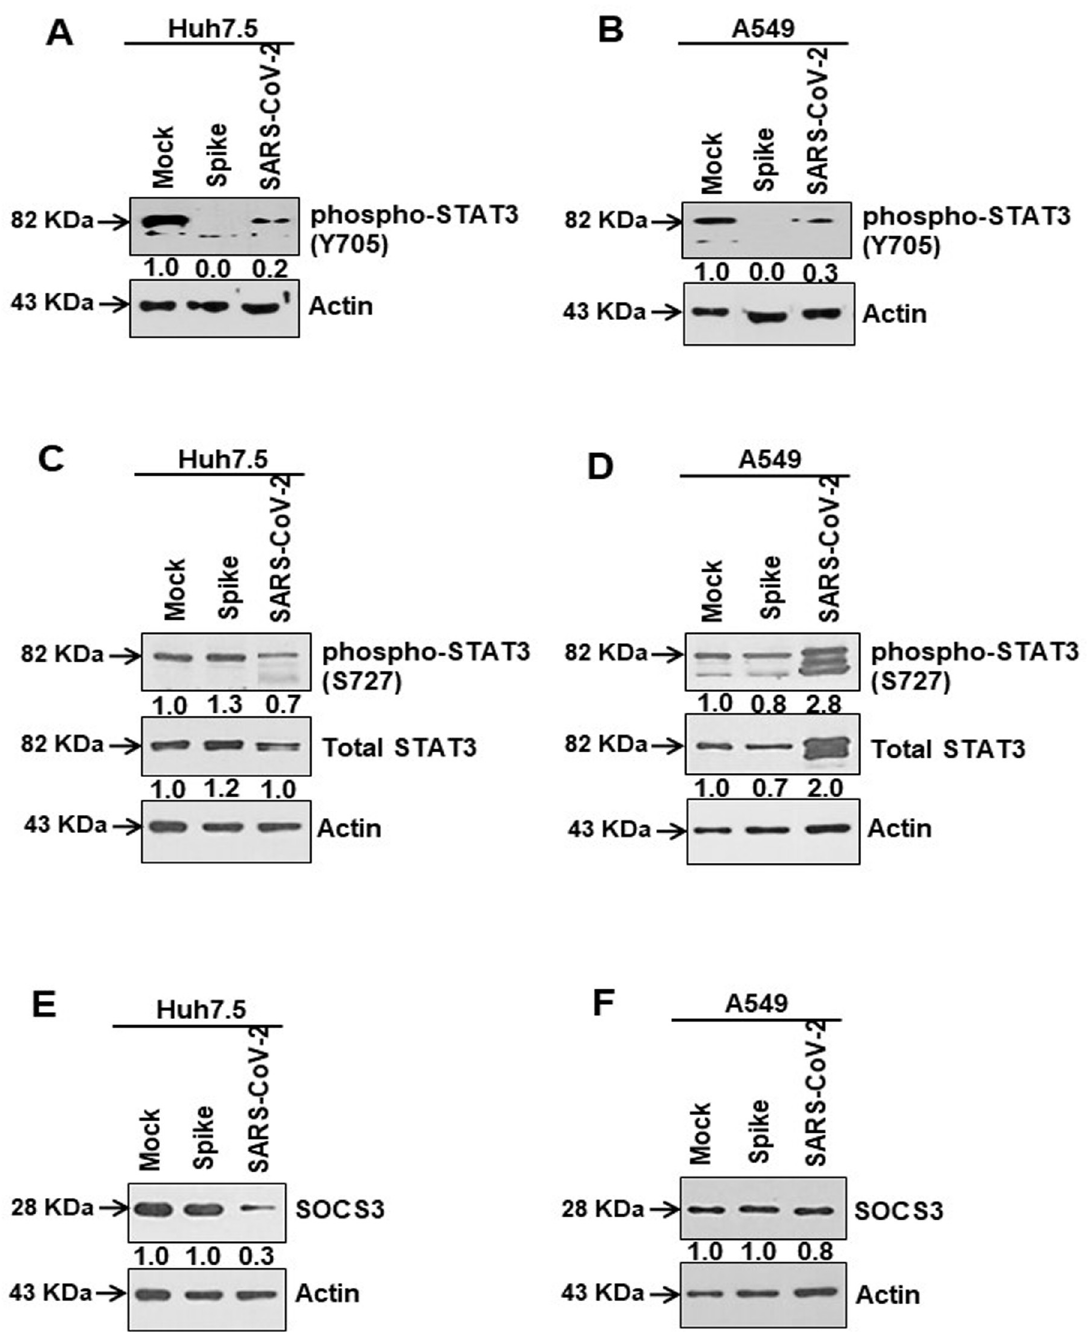
Fig 6. SARS-CoV-2 spike protein causes inhibition of tyrosine phosphorylation of STAT3. (A, B) Western blot analysis of phospho- STAT3 (Tyr705) and total STAT3 expression in Huh7.5 and A549 cell lysates prepared after 48 h of mock-treated or transient transfection of SARS-CoV-2 spike gene constructs or infection with SARS-CoV-2 virus. (C, D) Western blot analysis of phospho-STAT3 (Ser727) and total STAT3 expression in Huh7.5 and A549 cell lysates prepared after 48 h of mock-treated or transiently transfection of SARS-CoV-2 spike gene construct or infection with SARS-CoV-2 virus. (E, F) Western blot analysis of SOCS3 expression in Huh7.5 and A549 cell lysates prepared after 48 h of mock-treated or transiently transfected with SARS-CoV-2 spike constructs or infected with SARS-CoV-2 virus. Expression level of actin in each lane from the same gel is shown as a total protein loading control for comparison.